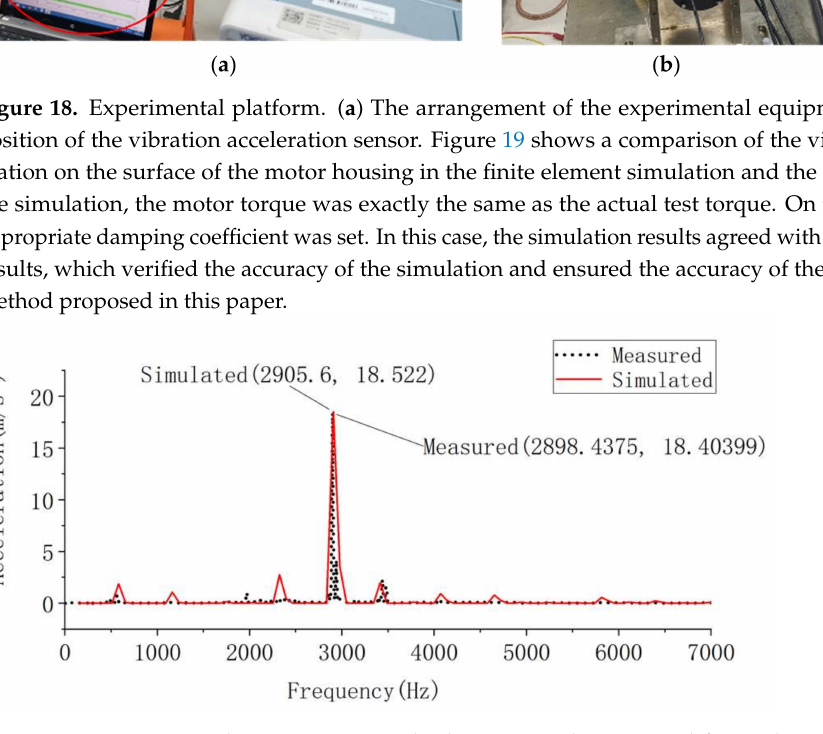
Figure 19. Comparison between measured vibration acceleration and finite element simulation